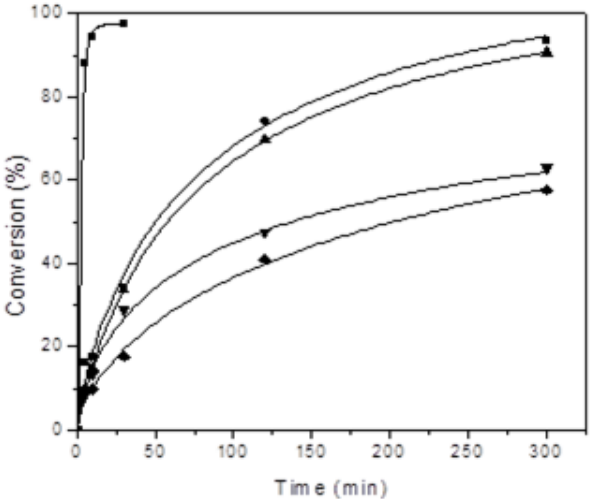
Figure 5. RCM of N,N-diallyl-2,2,2-trifluoroacetamide (DAF) with catalysts 4.8 ( (cid:4) ), 4.8 / SBA-15 ( ), 4.8 / MCM-48 ( (cid:78) ), 4.8 / SBA-16 ( (cid:72) ), and 4.8 / MCM-41 ( (cid:7) ). 30 ◦ C, Ru / DAF = 1:100, toluene, c 0 (DAF) = 0.15 mol / L. Taken from Reference [45] © Elsevier. Reproduced with the permission of